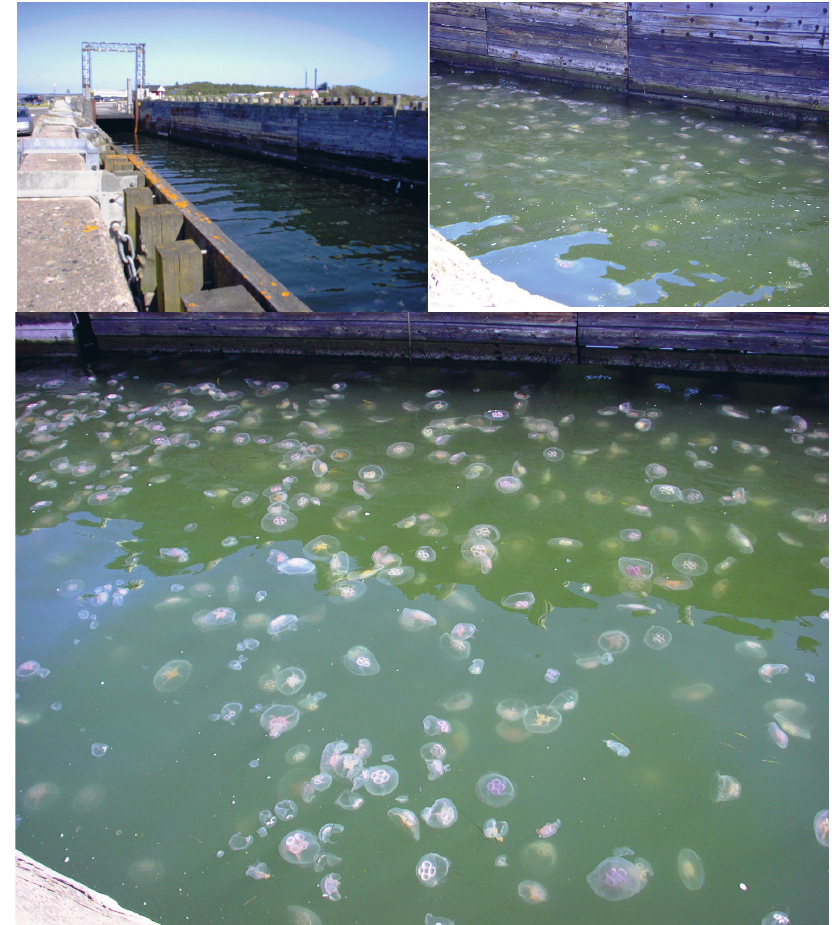
Figure 3. Mass occurrence of jellyfish ( Aurelia aurita ) in Limfjorden (Branden, Fursund) 27 June 2010. The water is probably green because the jellyfish have eliminated the usual zooplankton-grazing impact on the phytoplankton in the eutrophicated fjord system. Photo: Hans Ulrik